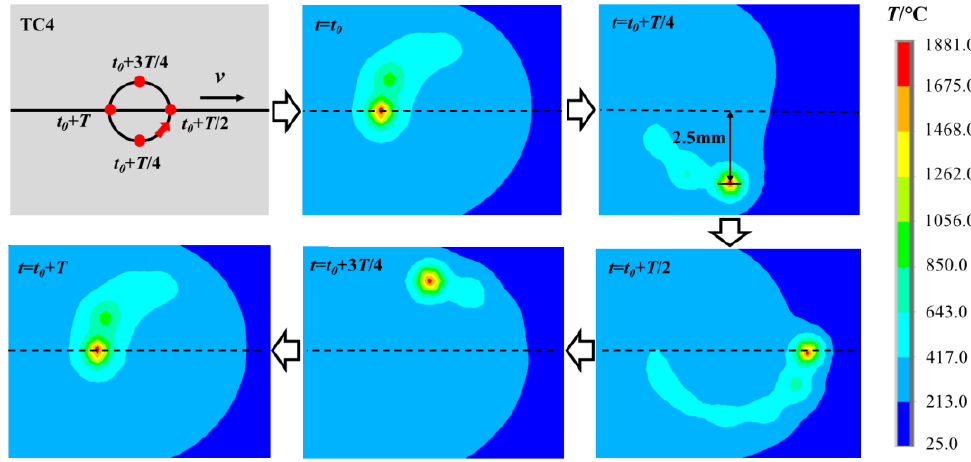
Figure 8. Temperature field of TC4 surface weld area in one cycle of rotating heat source.